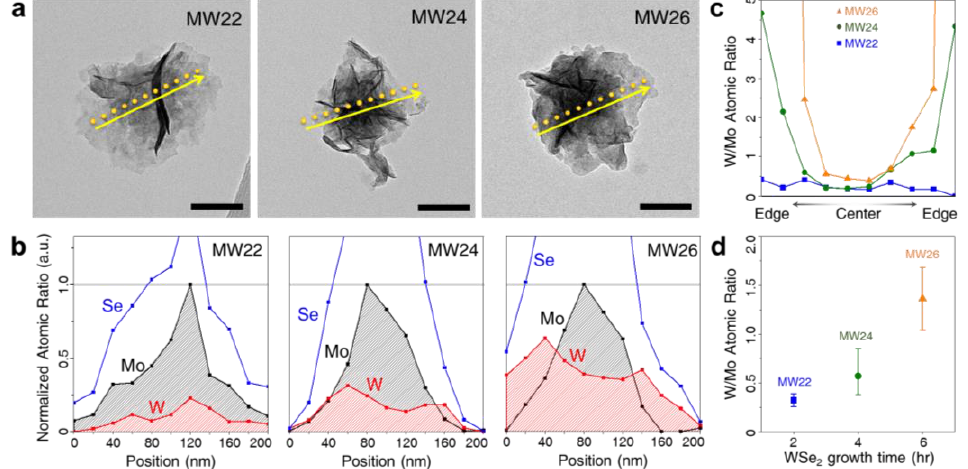
Figure 4. ( a ) TEM images of the MoSe 2 /WSe 2 heterostructures prepared from different WSe 2 secondary growth times (2, 4, and 6 h) on the primary MoSe 2 nanosheets pre-grown for 2 h. Scale bars, 100 nm. ( b ) Corresponding elemental ratios of Mo, W, and Se obtained from the point EDS spectra measured across the nanostructure domains. The point arrays of the measurements are highlighted by the yellow dots in ( a ). All the ratios were normalized to the positions with the highest Mo concentration (highlighted by the horizontal gray lines). ( c ) Profiles of W/Mo atomic ratio according to the relative positions from the domain center. ( d ) W/Mo atomic ratios as a function of the secondary WSe 2 growth time.